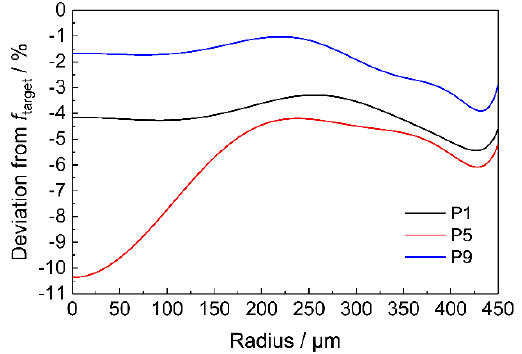
Fig. 3. Deviation of the measured surface data from the simulated target function for three different measured positions.